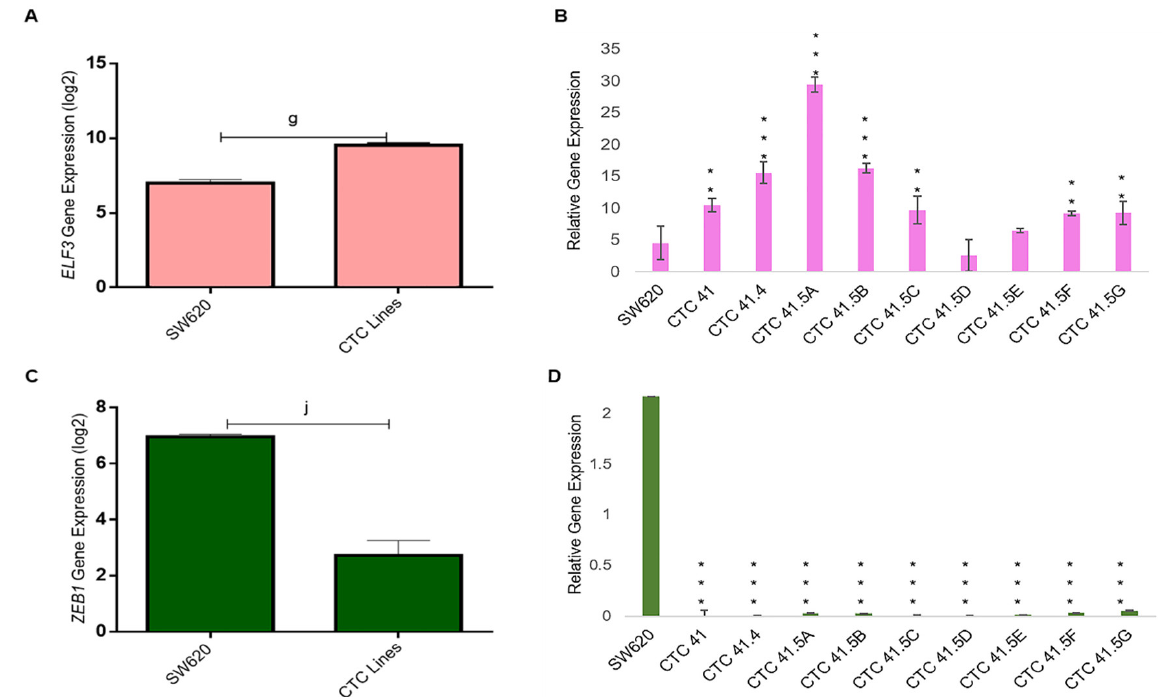
Figure 5. ELF3 and ZEB1 expression. ( A ) ELF3 mRNA level was significantly upregulated in all CTC lines compared with SW620 cells (microarray data). ( B ) RT-qPCR analysis of ELF3 in the nine CTC lines and in SW620 cells. ( C ) Comparison of ZEB1 expression in all CTC lines and in SW620 cells. ( D ) ZEB1 expression analysis by RT-qPCR in the nine CTC lines and in SW620 cells. g: p -value = 1.54 × 10 − 12 ; j: p -value = 1.20 × 10 − 17 . All the RT-qPCR results were normalized to the B2M expression level in each sample; ** p < 0.01, *** p < 0.001 compared with SW620 cells.